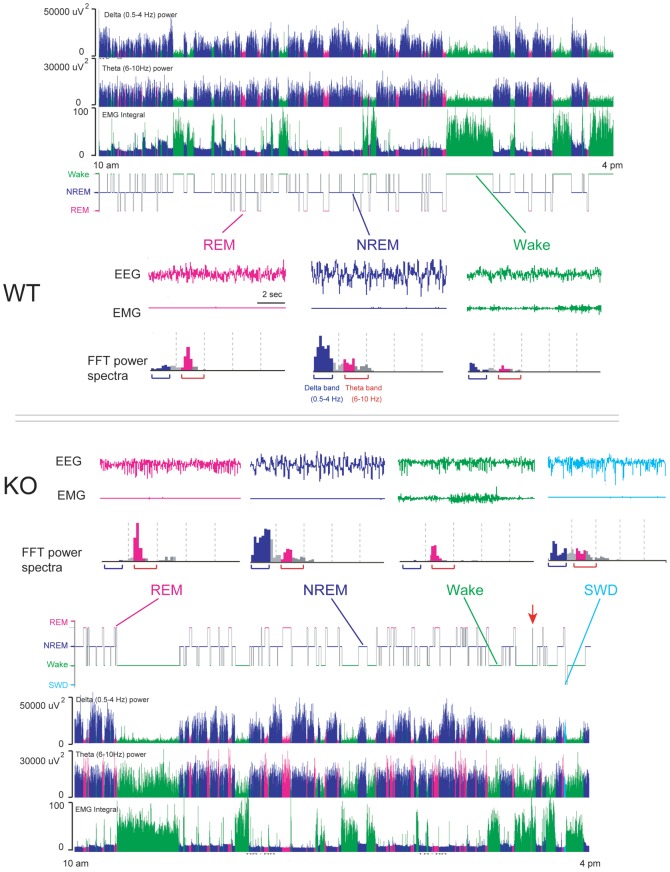
GAT1 KO mice displayed abnormal EEG activity.Representative examples for hypnogram, FFT-derived delta (0.5–4 Hz) power, FFT-derived theta (6–10 Hz) power and EMG activity in a WT (above) and KO mouse (below) from 10 am to 4 pm, as well as typical examples of EEG/EMG polygraphic recordings in each vigilance stage and corresponding power spectrum for 10-sec epochs for both genotypes. SWD, spike-wave discharge.